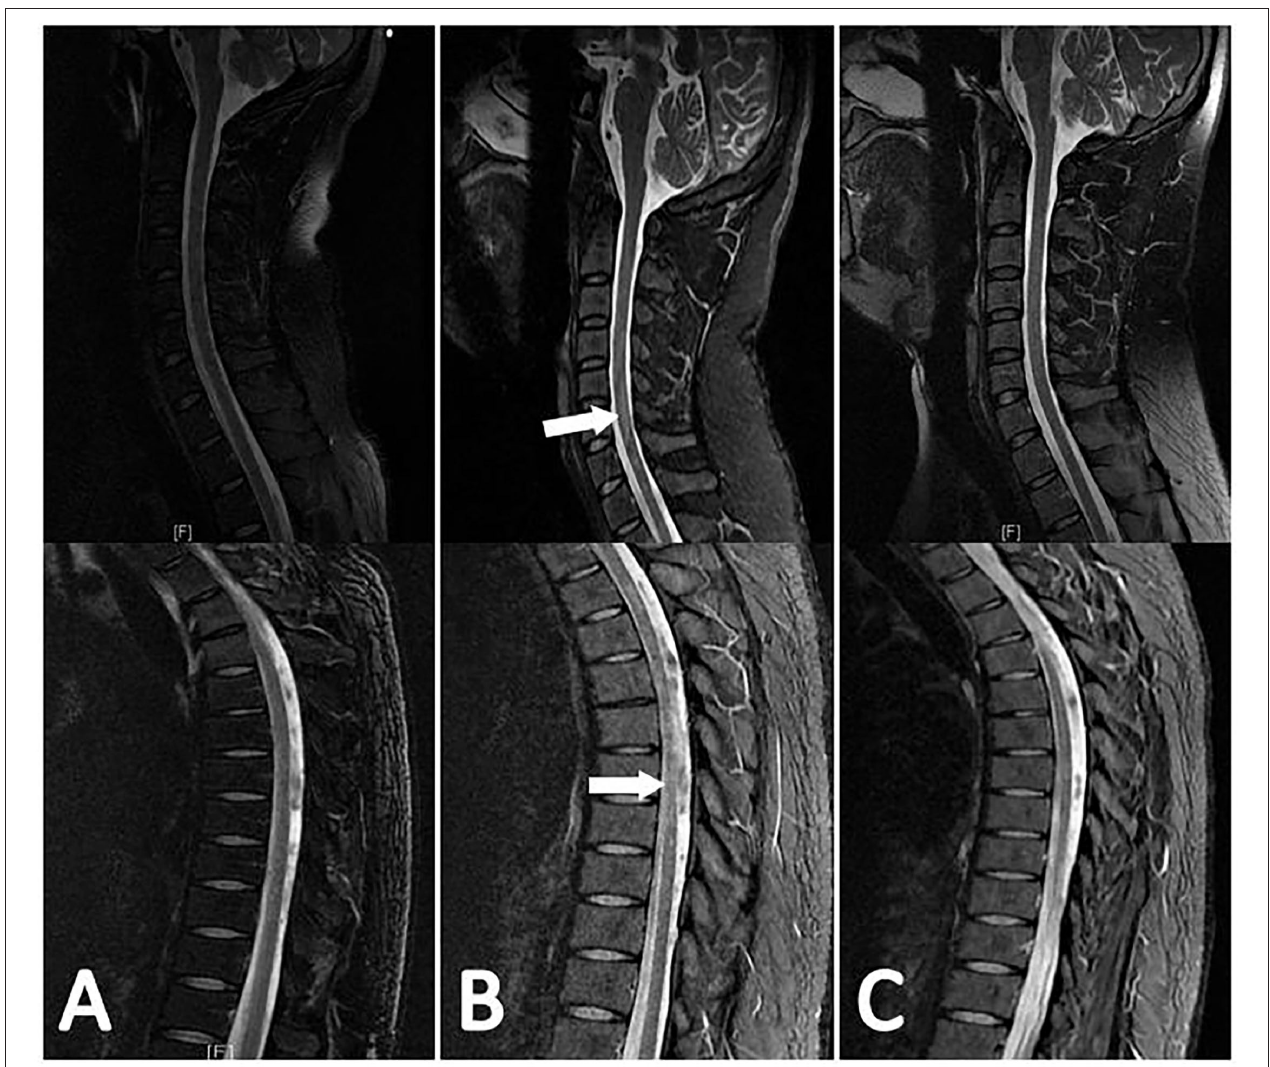
FIGURE 4 | The evolution of myelitis in the same patient is shown in Figure 3 . The patient’s first spinal MR examination showed no abnormalities (A) . 3 months later, there were multiple flaky hyperintensities in the cervical and thoracic spinal cord in the sagittal view of the T2-weighted sequence (B) . 4 months later, the original lesion was absorbed (C)